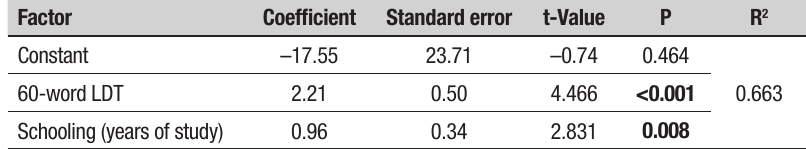
Table 4. Estimated IQ in control group by multiple linear